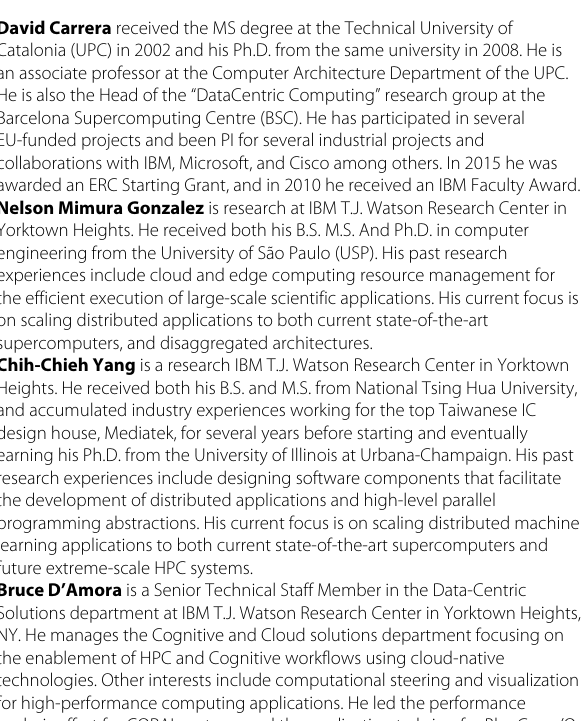
cluster. DRMaestro reduces the total job makespan with a speedup of up to ≈ 1.20x and decreases the number of QoS violations up to ≈ 2.64x compared with similar orchestrator based on flow-network discipline that does not support resource